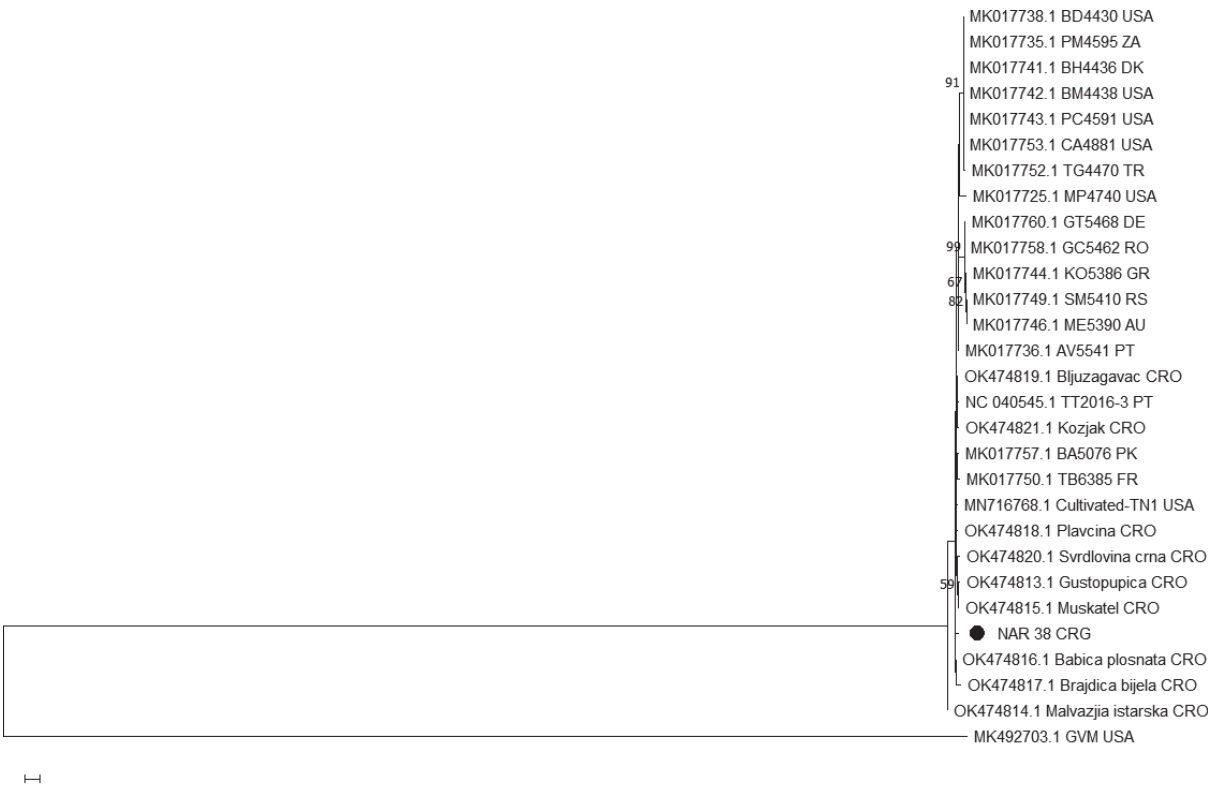
Figure 3. Phylogenetic tree generated from partial nucleotide sequences of the GVH RdRp region. Bootstrap values were obtained using 1000 replicates. Only branches having a support above 50% are indicated. The Sardinian GVH isolate detected in this study is indicated by a black dot. The phylogenetic tree was reconstructed using the maximum likelihood algorithm implemented in the MEGA X software. Seven- teen isolates from different countries (United States of America - USA, Portugal - PT and Croatia - CRO) were selected from GenBank and used to construct the tree. A GVM sequence (MK492703) was used as the rooting